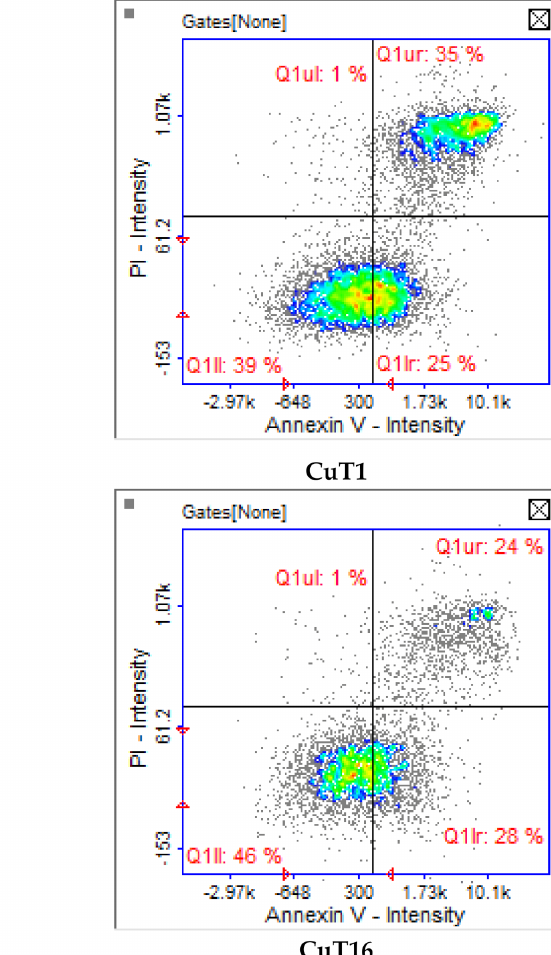
Figure 6. Apoptosis/necrosis detection by image cytometry. A375 cells were treated with CuT1, Cu10, CuT16 in concen- trations corresponding to IC 50 values (69.92, 26.05, and 144.60 µ M respectively) or DMSO as vehicle in control cultures. The results show one representative experiment of three independently performed. Q1II—live, Q1Ir—early apoptotic, Q1ur—late apoptotic, and Q1uI—necrotic